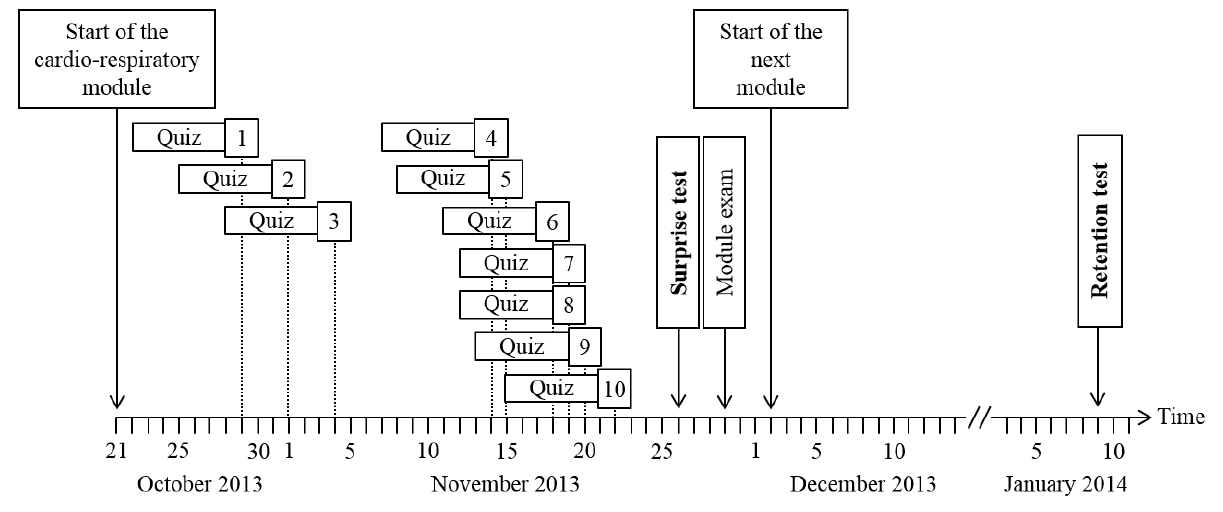
Figure 1. Study outline (numbers in boxes correspond to the 10 lectures used for this study, and vertical dotted lines indicate the date on which live lectures were held). For each lecture, podcasts were available over a period of 7 days leading up to the live lecture. During this time, students were invited to submit their quiz